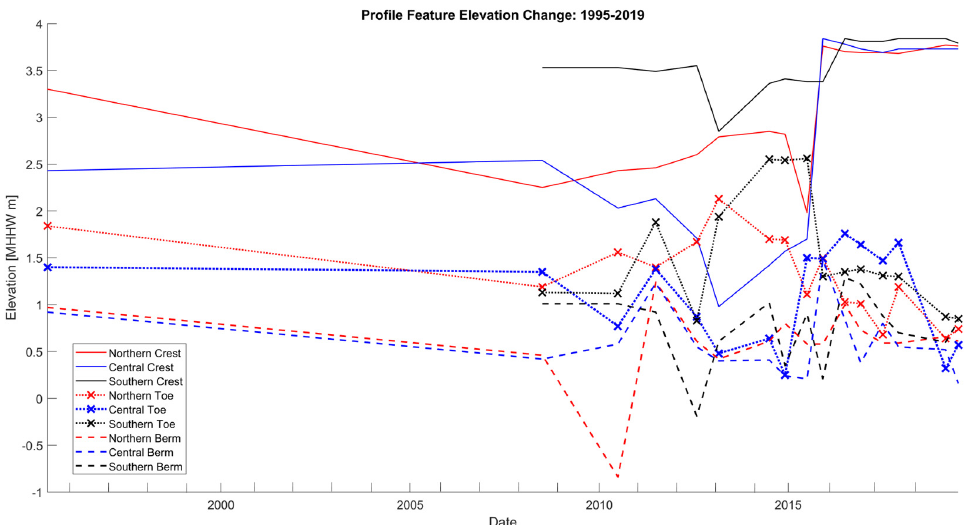
Figure 2. Elevations relative to MHHW for the northern, central, and southern regions of the study site. The features tracked include the dune crest, dune toe, and berm. The missing points indicate that the feature was not detectable in the data and most likely not present along the profile. Each line represents a profile feature, in which the colors are the same location and the line types are the same feature. The profile surveys were performed by DNREC and are made publically available upon request.